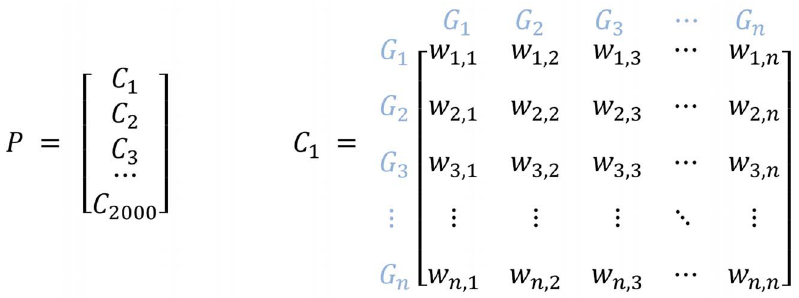
Figure 5. Population and chromosome weight matrix. A population of 2000 chromosomes is initially generated and maintained at each new generation. Each chromosome contains a matrix of interaction weights between every pairing of genes. P =population, C =chromosome, G =gene, w 2,1 =the weight of the interaction from gene 1 to gene 2.